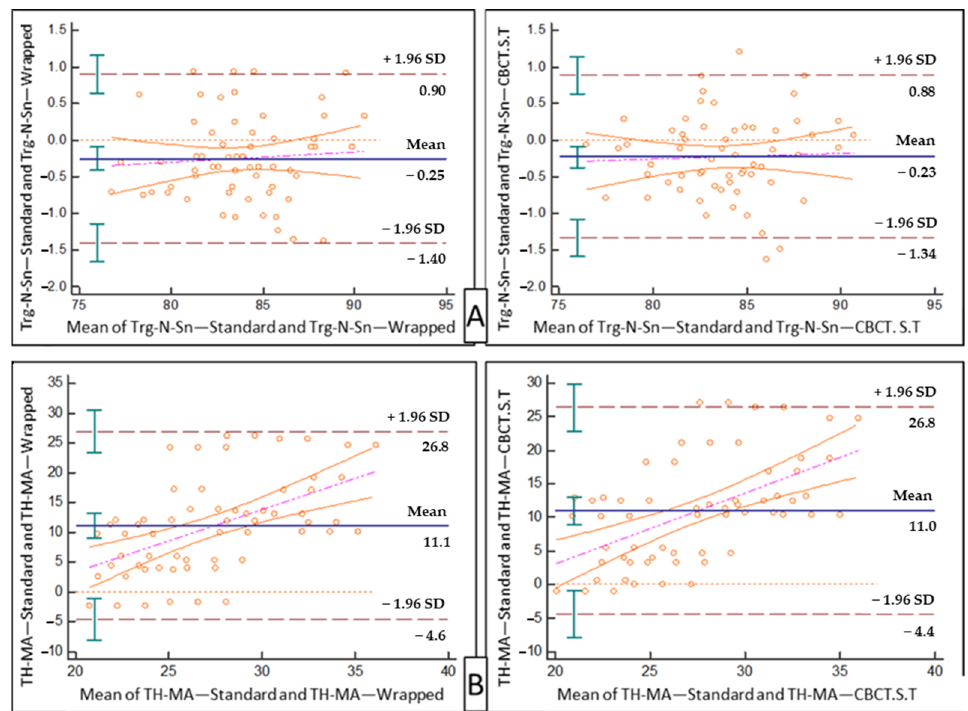
Figure 6. Two samples of Bland–Altman results. ( A ) The result of the two studied methods against the standard method for Trg N’ .Sn. (°). ( B ) The results of the two studied methods against the standard method for TH-MA (°).